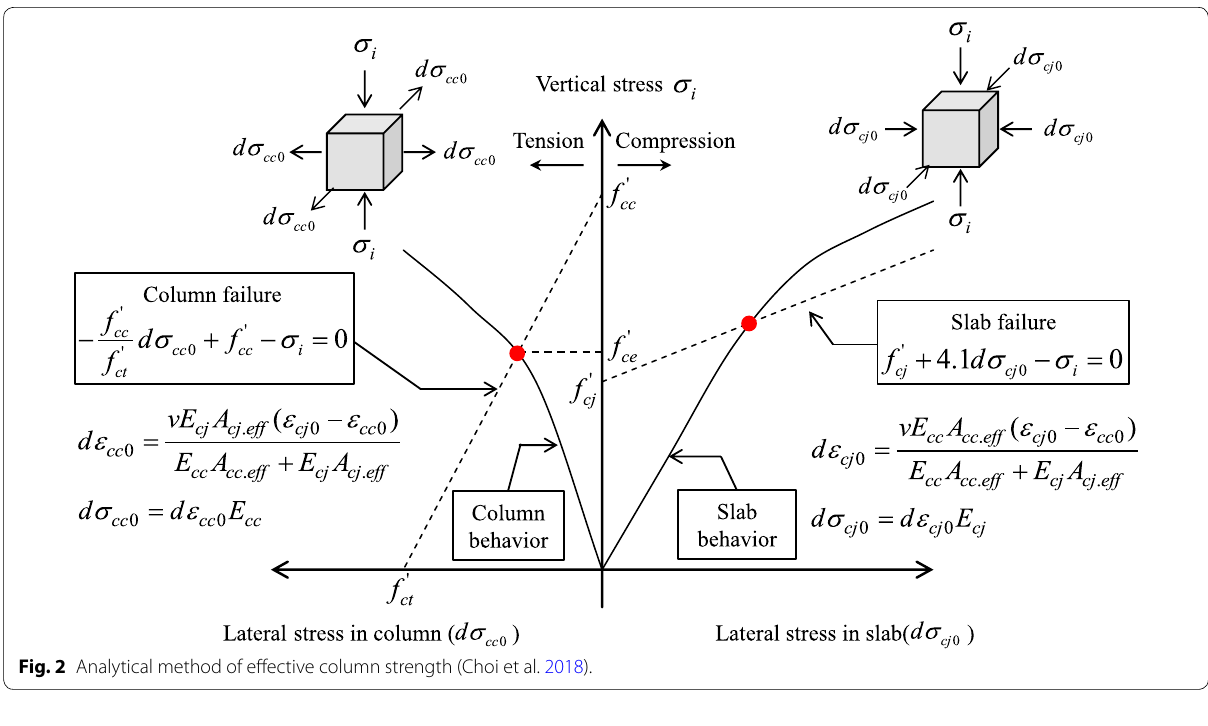
Fig. 2 Analytical method of effective column strength (Choi et al.